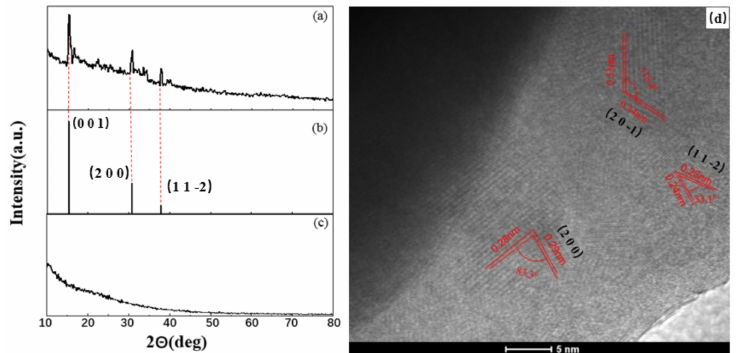
Figure 3. Space structure of composite nano-PAA-CuCl 2 . XRD patterns of ( a ) the synthesized nano- PAA-CuCl 2 , ( b ) standard CuCl 2 spectrum, ( c ) substrate nano-PAA film, and ( d ) HR-TEM